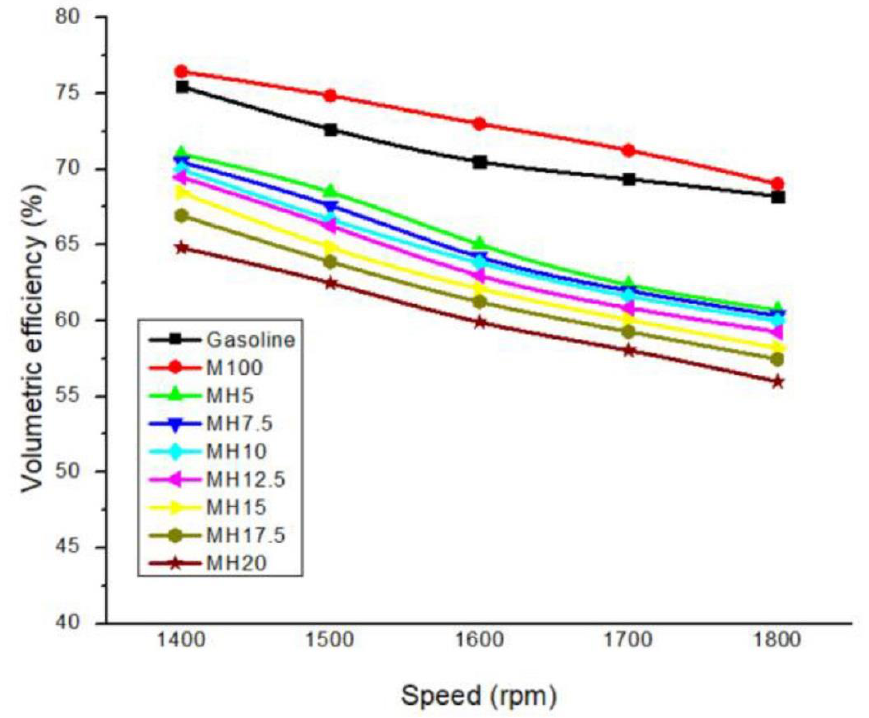
Figure 7. Volumetric efficiency changes with different percentages of hydrogen in the SI engine [79].